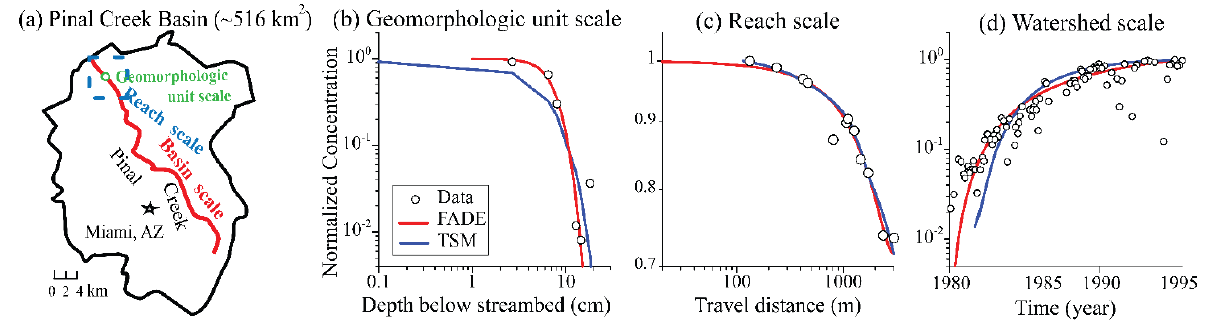
Figure 3. Application 2: ( a ) three scales at the Pinal Creek Basin, Arizona (modified from Puckett et al. [1]). ( b – d ): The measured (symbols) vs. modeled (lines) BTCs using the FADE (7) for the dissolved Mn transport at all three scales in the stream.